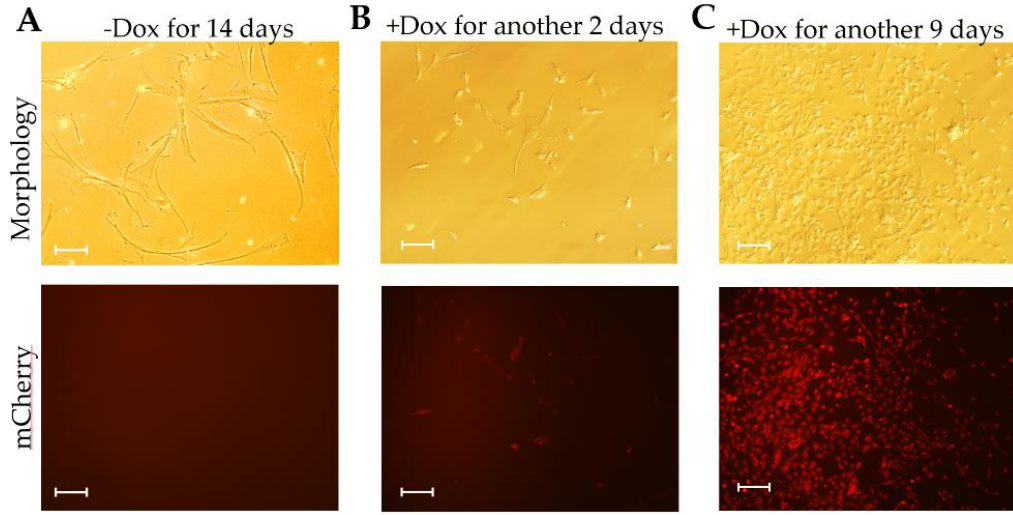
Figure 7. Morphology and phenotypic analysis of the CIPGCs after Dox withdrawal followed by Dox induction. ( A ) The CIPGCs became ageing after culturing without dox for 14 days and had no expression of mCherry. The ageing CIPGCs were then re-treated with dox induction for another two days ( B ) or nine days ( C ), and the mCherry expression was recovered. Bar at 50 µm.